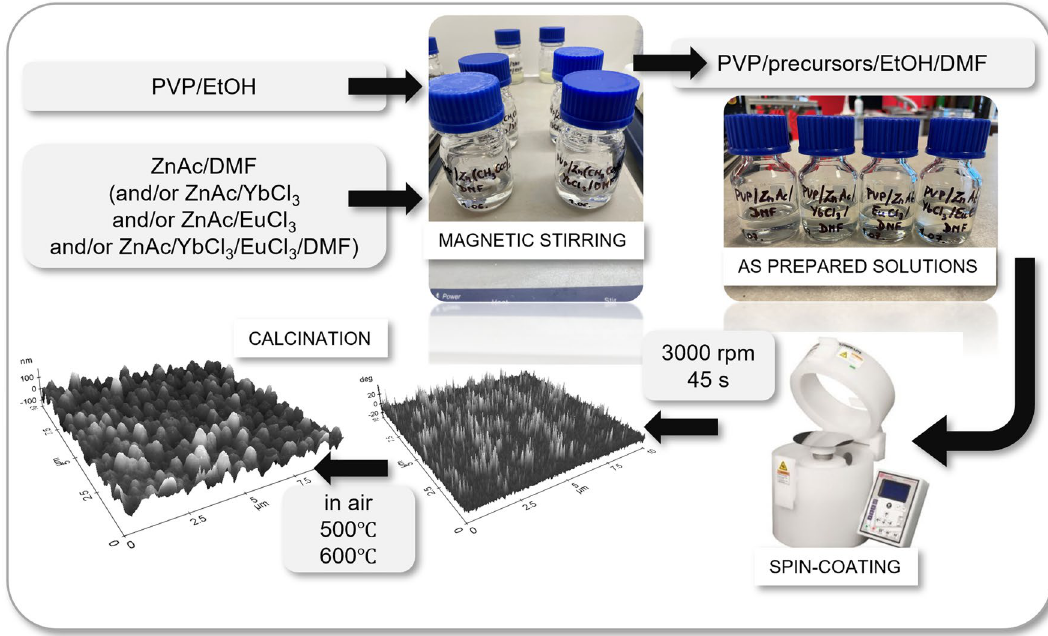
Figure 1. Scheme presenting the methodology of preparing hybrid thin